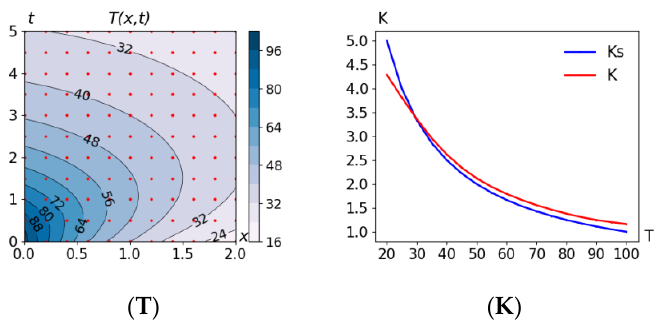
Figure 11. SvF solution of Problem 5.8: ( T ) contour lines of T(x,t) ; ( K ) the thermal conductivity coefficient.